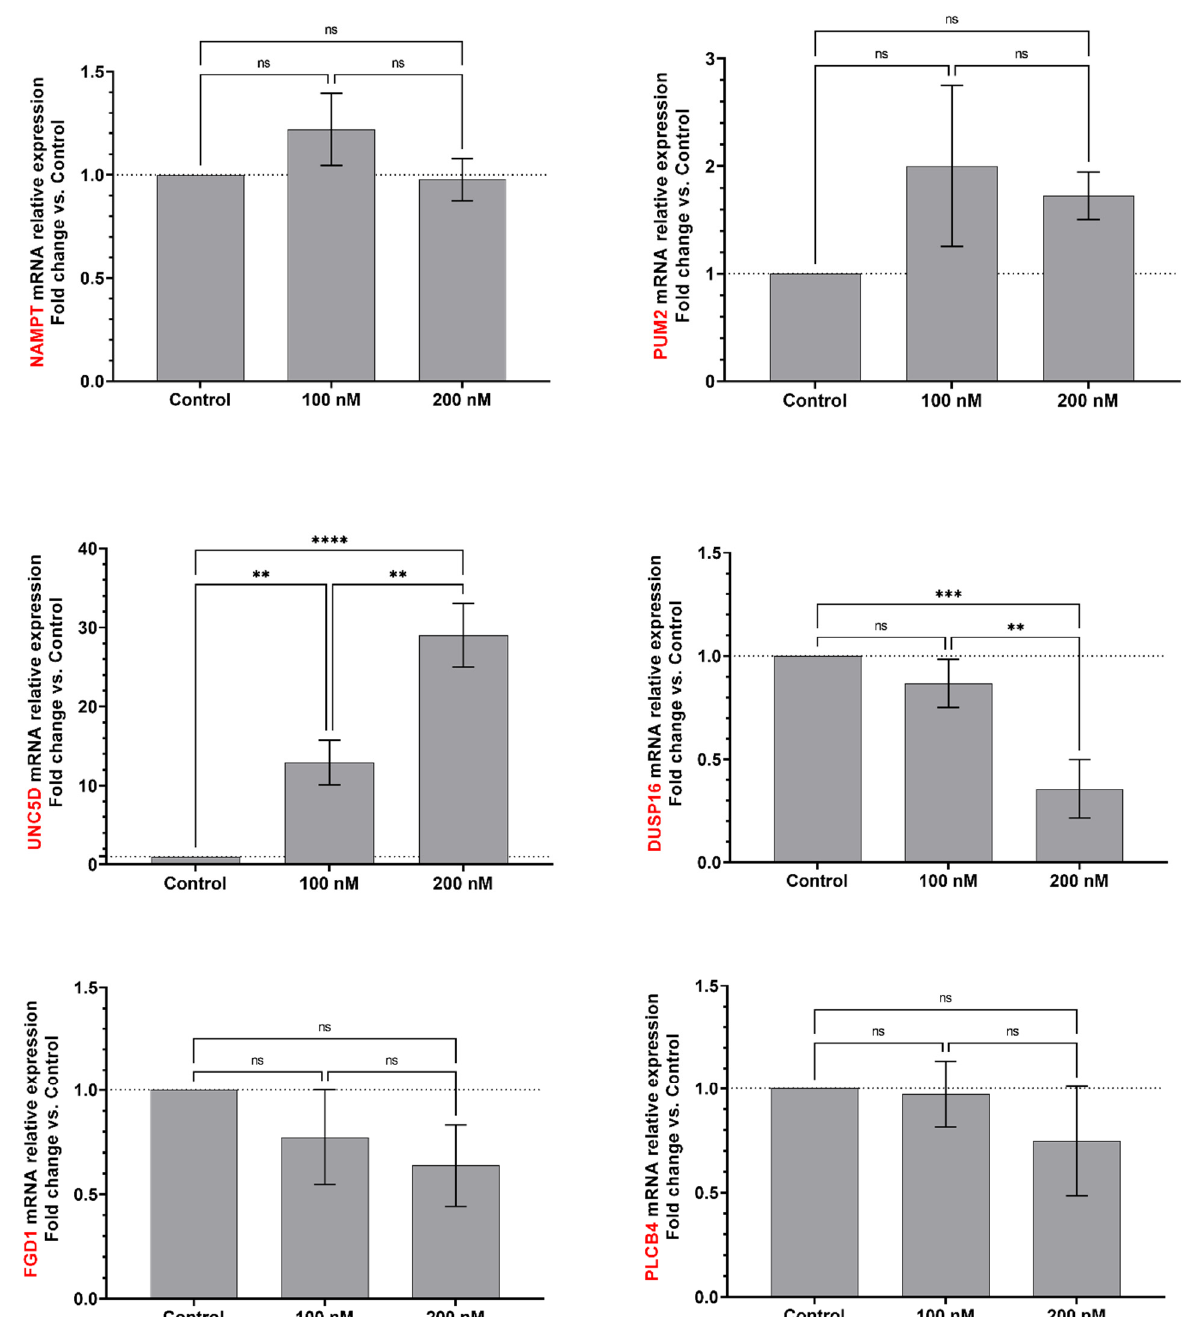
Figure 5. EBOV miR-MAY-251 may regulate several human host mRNA targets. NAMPT, PUM2, UNC5D, DUSP16, FDG1 and PLCB4 genes, which are potentially involved in viral infection mech- anisms, were monitored by RT-qPCR (mRNA relative expression) after transfection of EBOV miR- MAY-251 mimic (100 and 200 nM) in Huh7 cells. qPCR data were normalized with a reference gene (ACTB), reported to control (mock control) and expressed with a relative quantitation method (ddCT). Statistical analysis: Data were calculated from three biological replicates and expressed as means ± SD. One-way analysis of variance (ANOVA) and Tukey’s multiple comparisons test were used, and statistically significant differences (fold change vs. control) are indicated as follows: ** p < 0.01; *** p < 0.001; **** p < 0.0001. ns, non significant.